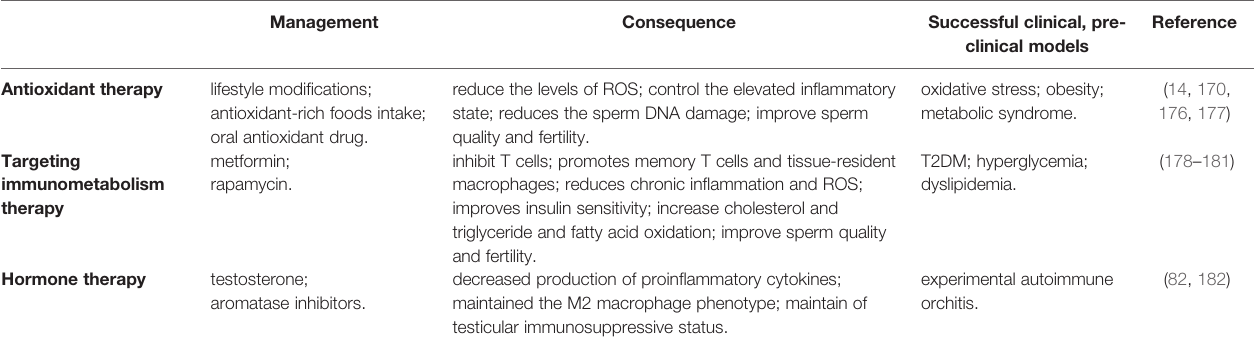
TABLE 1 | Summary of speci fi c anti-in fl ammatory therapy on male